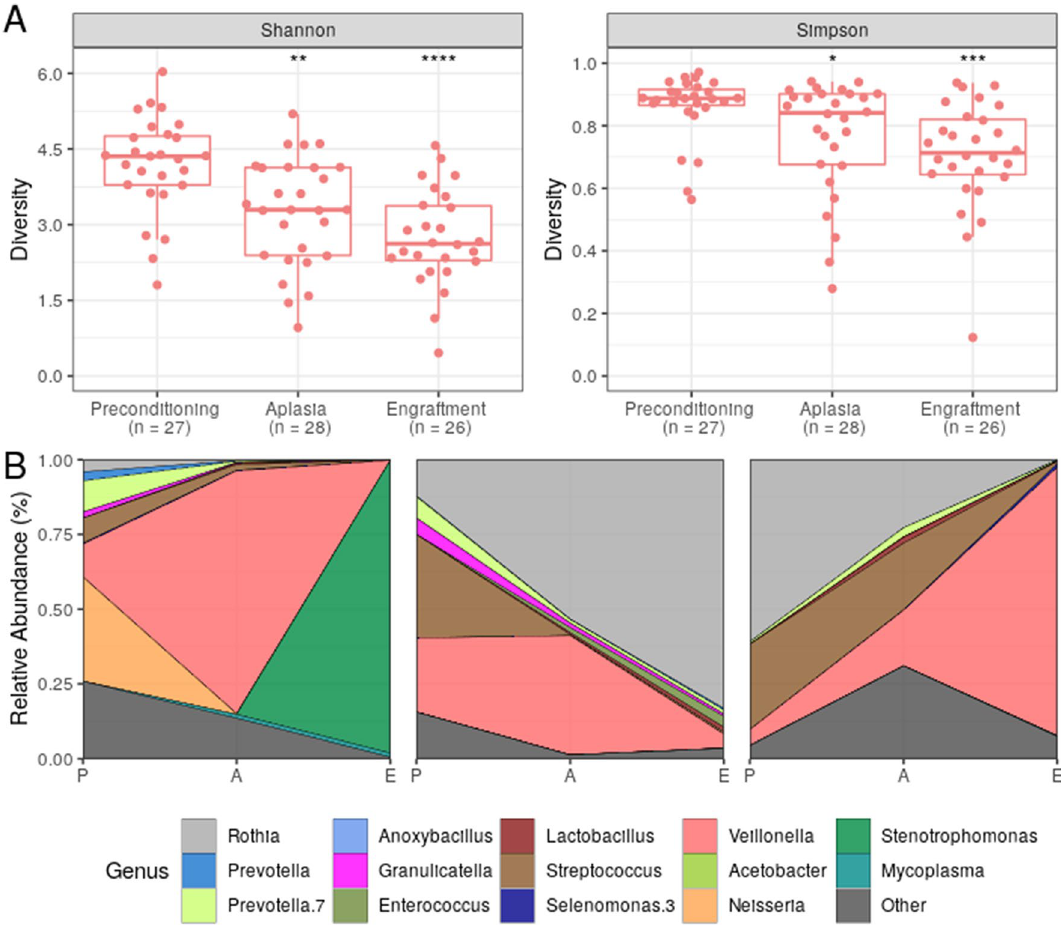
Figure 1. Bacterial diversity within the oral mucosa decreases during allo-HSCT. ( A ) Oral microbiota (OM) bacterial diversity boxplot at preconditioning (n = 27), aplasia (n = 28), and engraftment (n = 26) as measured by either Shannon index (left panel) or Simpson index (right panel). Mann–Whitney U tests were used with the preconditioning collection as the reference for comparisons. The boxes highlight the median values and cover the 25th and 75th percentiles, with whiskers extending to the more extreme value within 1.5 times the length of the box. Outliers are represented explicitly. Asterisks represent statistical significance: * P < 0.05; ** P < 0.01; *** P < 0.001; **** P < 0.0001. ( B ) OM genera relative abundance composition across transplantation phases for three representative patients showing the decrease in bacterial diversity. Only genera showing relative abundance ≥ 30% in at least one study sample or relative abundance ≥ 5% in at least 25% of study samples are shown. P preconditioning, A aplasia, E